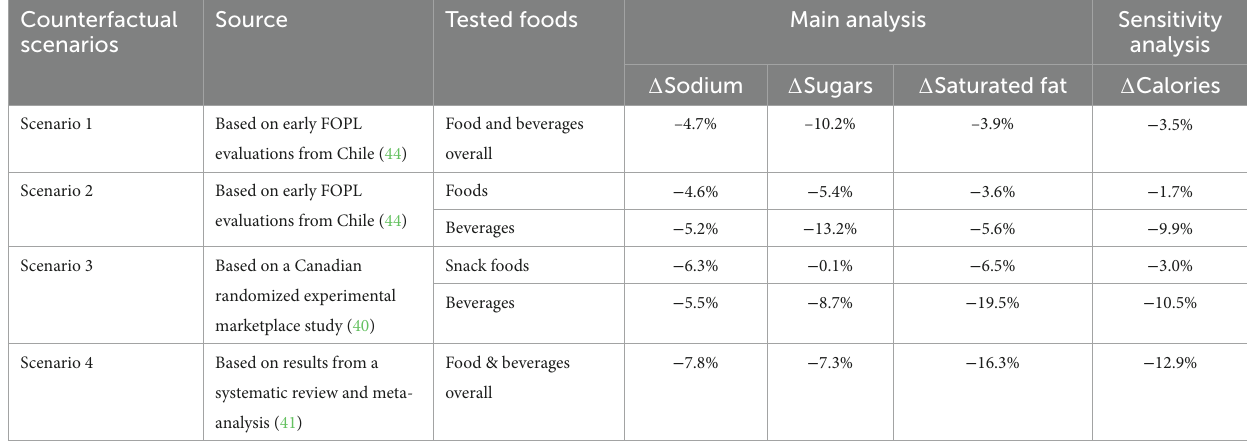
TABLE 1 Percentage change of critical nutrients and calorie content of food and beverage purchases applied for each FOPL counterfactual scenario (summary). Counterfactual